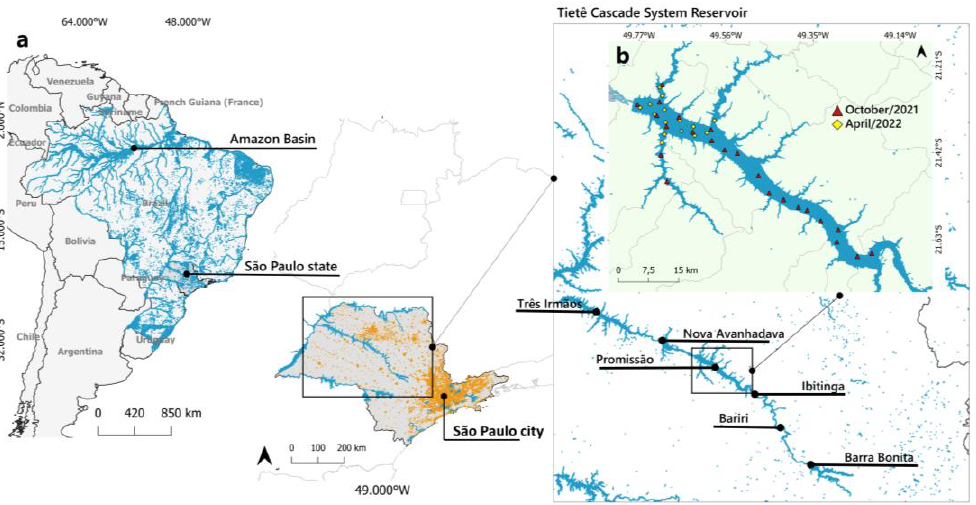
Figure 1. ( a ) Brazilian rivers; highlight for the state of São Paulo and the Tietê Cascade System. ( b ) Promissão Reservoir. Red and yellow points highlighted in Promissão Reservoir correspond to samples measured during the field campaigns in October/2021 and April/2022.